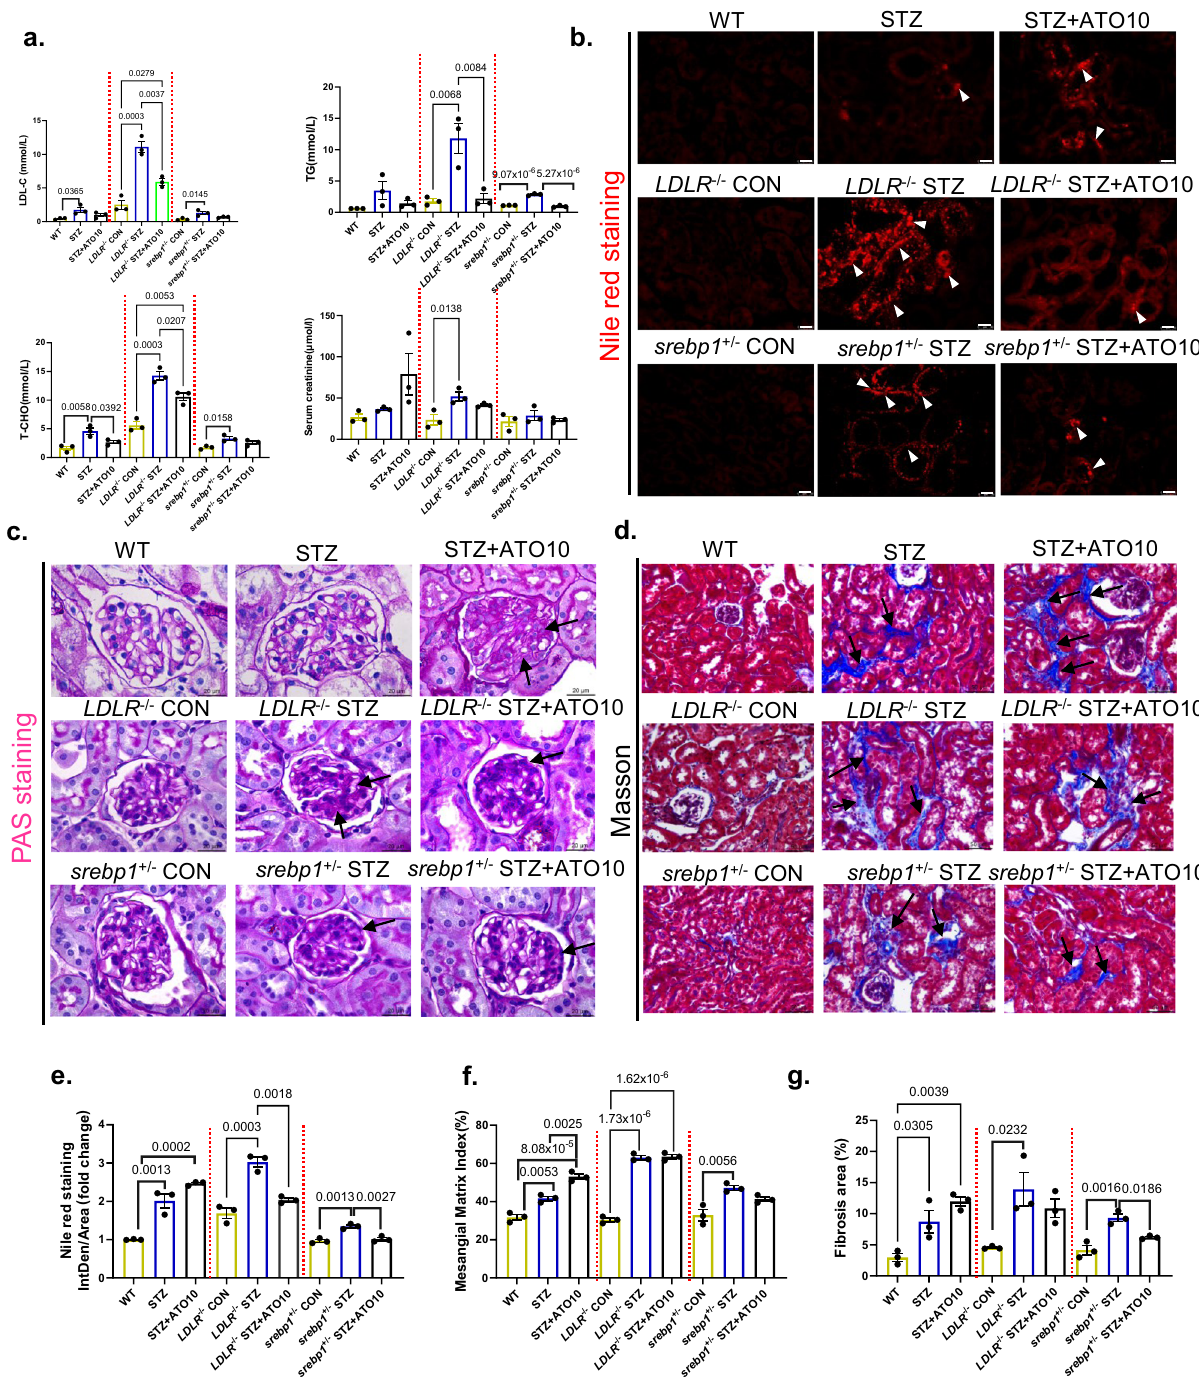
Fig. 9 | LDLRor SREBP-1 ‑ de fi cient attenuates renal lipiddeposition inducedby long-term statins administration in STZ-induced diabetic mice. All mice were ~30 weeks old. a Lipid pro fi le and serum creatinine in STZ-induced diabetic mice. n =3ineachgroup.Dataareexpressedasmeans±SEM. b Representativeimagesof Nile red staining. The lipid drops were stained in red, and the redder dots in the fi gure, the more lipid accumulation. Arrows represent lipid drops in renal tubular epithelial cells. Original magni fi cation ×400. Scale bar: 50 µ m. c Representative images of PAS staining. Original magni fi cation ×1000. Scale bar: 20 µ m. Arrows represent mesangial expansion. d Representative images of Masson ’ s trichrome